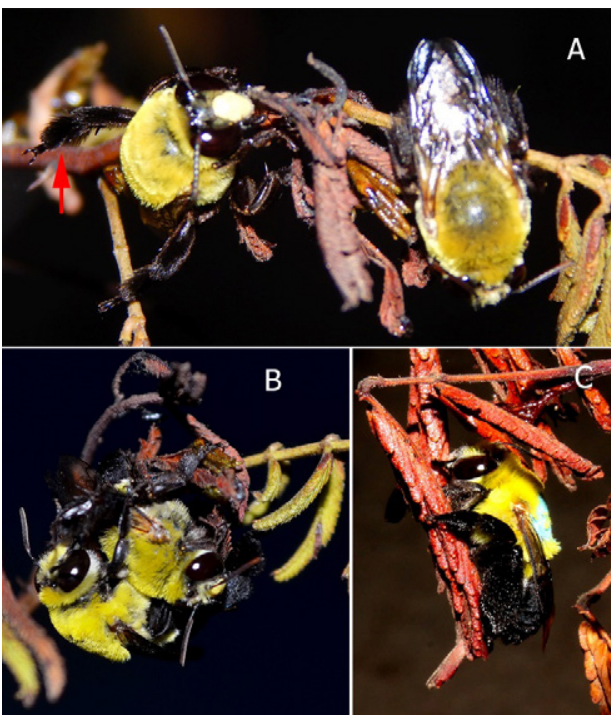
Fig 2 . Behaviors observed in the sleeping aggregations on branches of Mimosa tenuiflora branches in a Caatinga area, Petrolina, Brazil, July 2017. (a) Male with hind leg (red arrow) raised, (b) male sleeping aggregation, (c) female sleeping alone in a